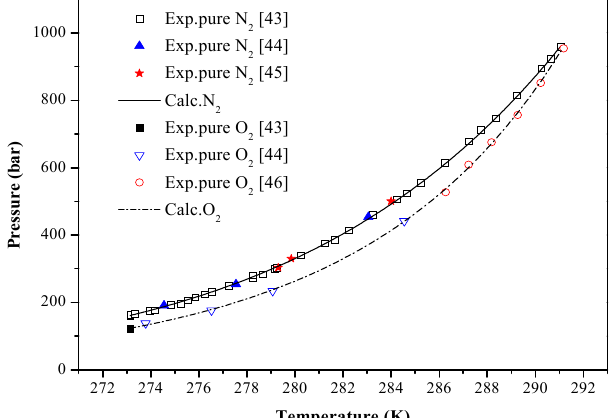
Figure 7. Experimental and predicted phase equilibrium conditions for N 2 /O 2 + water systems. van Cleeff and Diepen [43], squares □ , ■ ; Mohammadi et al. [44], triangles ▲ , ▽ ; Duc et al. [45], stars ★ ; van Cleeff and Diepen [46], circles ○ .